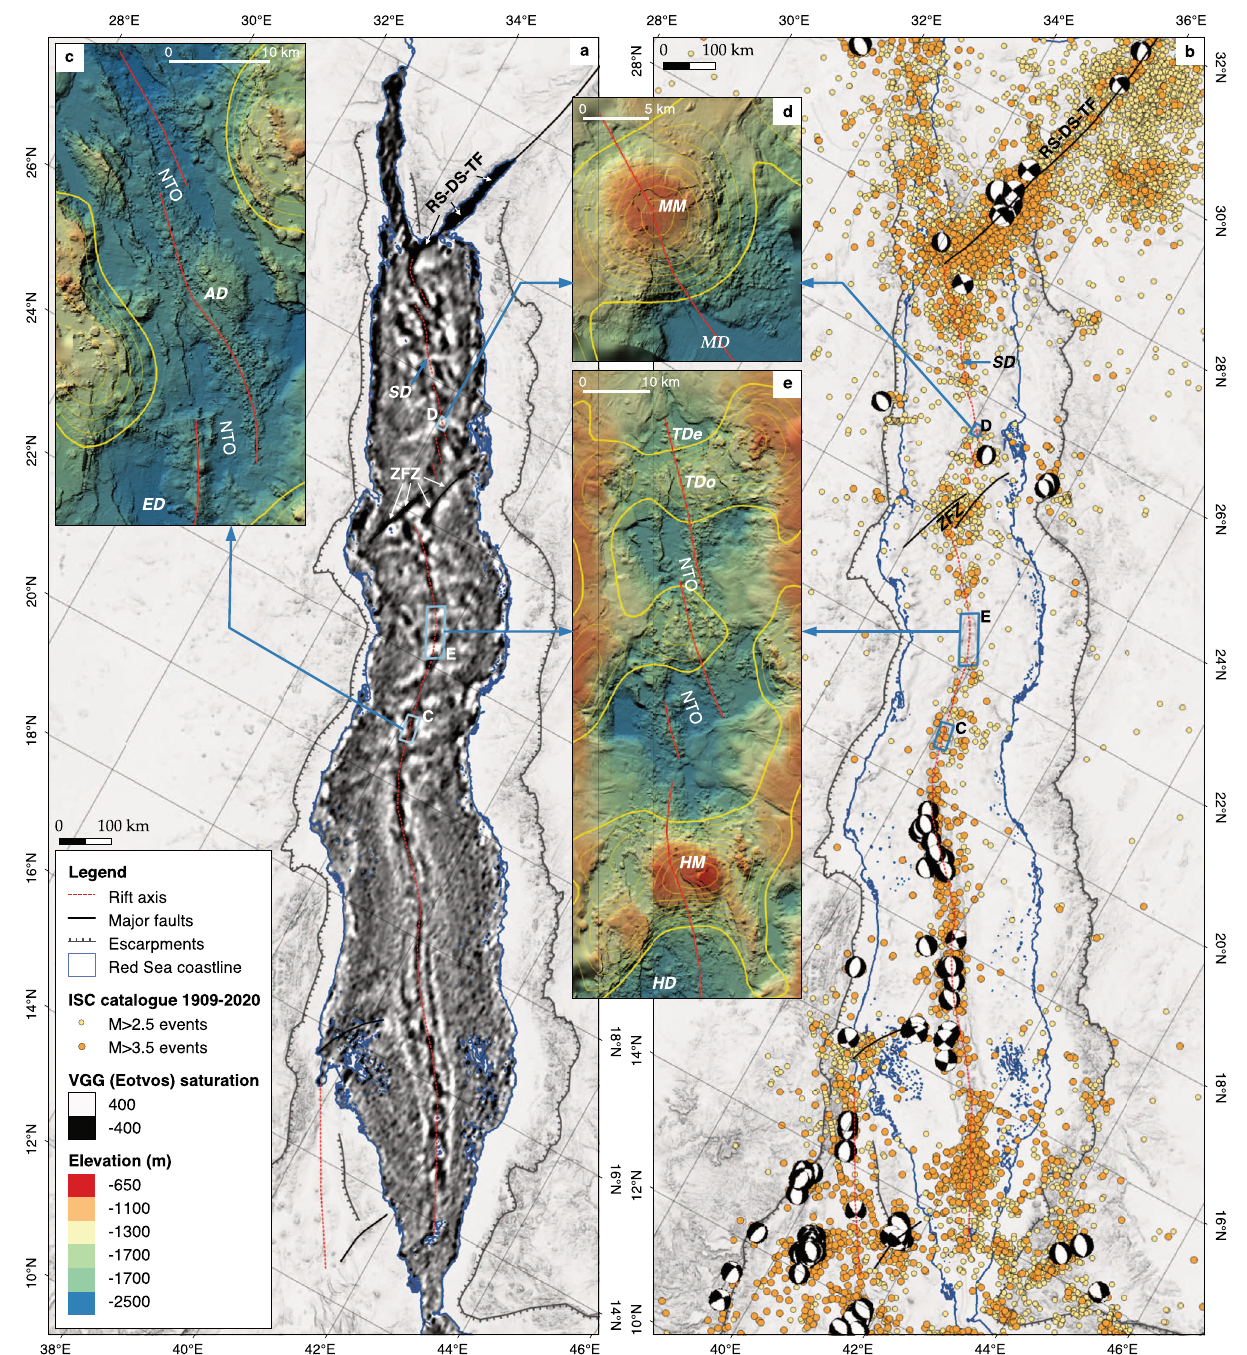
Fig. 5 Vertical gravity gradient, seismicity and bathymetry of the Red Sea Rift. a The vertical gravity gradient (VGG) 16 data reveal hidden structures under the salt and sediment blankets in the Red Sea. Rift-perpendicular, stripy positive anomalies represent off-axis segmentation trails, caused by along-axis crustal thickness variations 26 , known from slow-spreading mid-ocean ridges elsewhere 17 (see also Figs. 3 and 6). Shaban Deep (SD) represents the northernmost site where a salt-free rift axis was observed. First-order transform offsets are represented by strong negative VGG anomalies and are only visible in the Zabargad fracture zone (ZFZ) and the Red Sea – Dead Sea transform fault (RS-DS-TF). b The position and intensity of earthquake epicentres M>2.5 between 1906 and 2020 (International Seismological Centre, ISC-GEM Earthquake Catalogue 31 ) is delineating the plate boundaries and areas of transform faults in the Red Sea. Global CMT moment tensor solutions 31 indicate strike-slip for the northern boundary of the Danakil block as well as for the Red Sea – Dead Sea transform fault in the Gulf of Aqaba (symbols are drawn on top of epicentre positions). c High-resolution ship bathymetry showing along axis details of the ocean crust in area north of Erba Deep (ED) around the Aswad Dome (AD). d Bathymetric details of the prominent Mabahiss Mons volcano (MM) and the Mabahiss Deep (MD) in the northern Red Sea. e Bathymetry of the Red Sea Rift from Thetis Deep (TDe) to Hatiba Deep (HD) with the large axial volcanic centres of the Thetis Dome (TDo) and Hatiba Mons volcano (HM). The large dome volcanoes and axial highs are the recent magmatic centres of the segmentation trails seen in VGG and where eventually seismic quiet zones are present. Yellow lines in panels ( c – e ) represent VGG contours ≥ 70E (100E steps), red line = rift axis, NTO = second- order non-transform offset (for details see text); C, D and E indicate the position of the detail